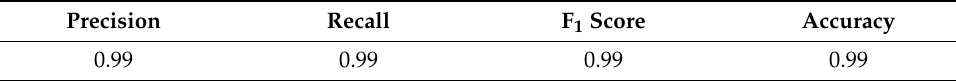
Figure 7. Classification and labelled images with the test data. Table 6. Performance metrics of the test